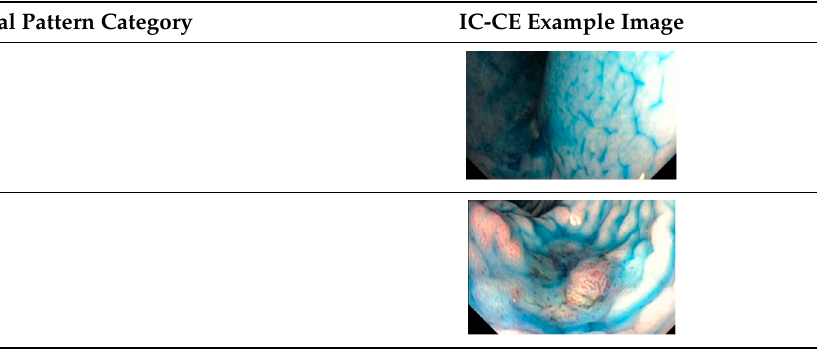
Table 2. Examples of mucosal categories recognized in indigo carmine chromoendoscopy (IC-CE) of the gastric mucosa of dogs.